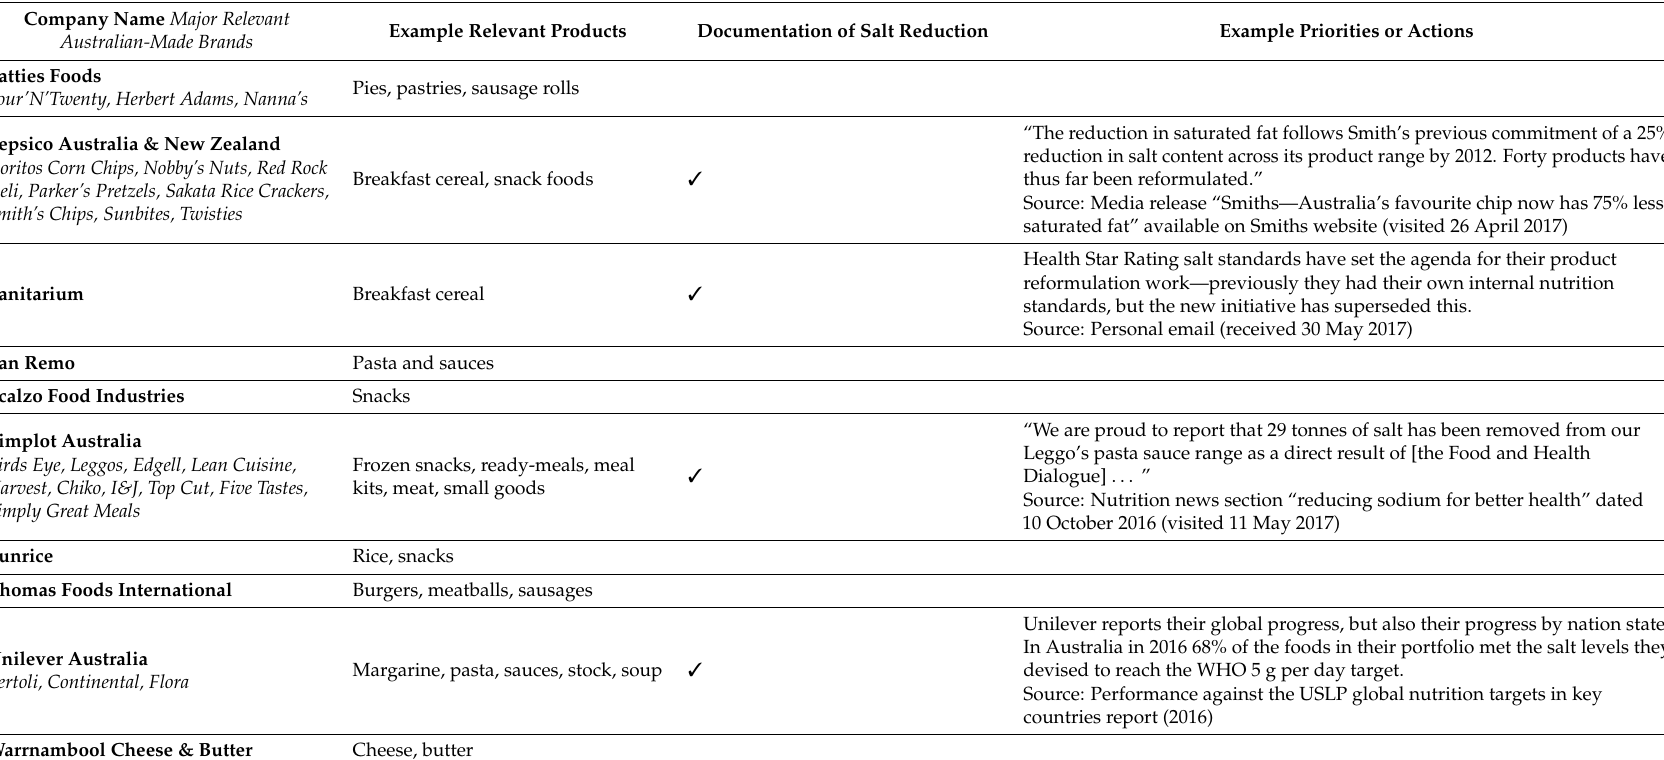
Table Key: Obtained a tick (Reformulation concerning any salt/sodium nutrients; Reduced-salt product lines; Described participation in Food and Health Dialogue, Heart Foundation Tick program, the Healthy Food Partnership, Industry reformulation activities); Did not obtain a tick (Reformulation concerning other nutrients; No evidence of Australian product lines reducing